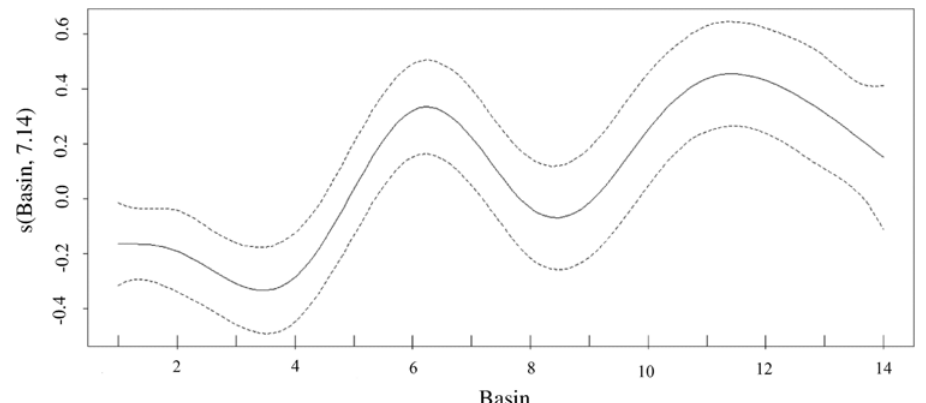
Fig 4. The estimated smoothing curve for fishway basin beginning at the entrance way at basin 1. The y-axis shows the contribution of the smoother to the fitted values of ODBA. The solid line is the fitted curve and the dashed lines are the approximate 95% pointwise confidence limits. Model degrees of freedom are given parenthetically in the y-axis label